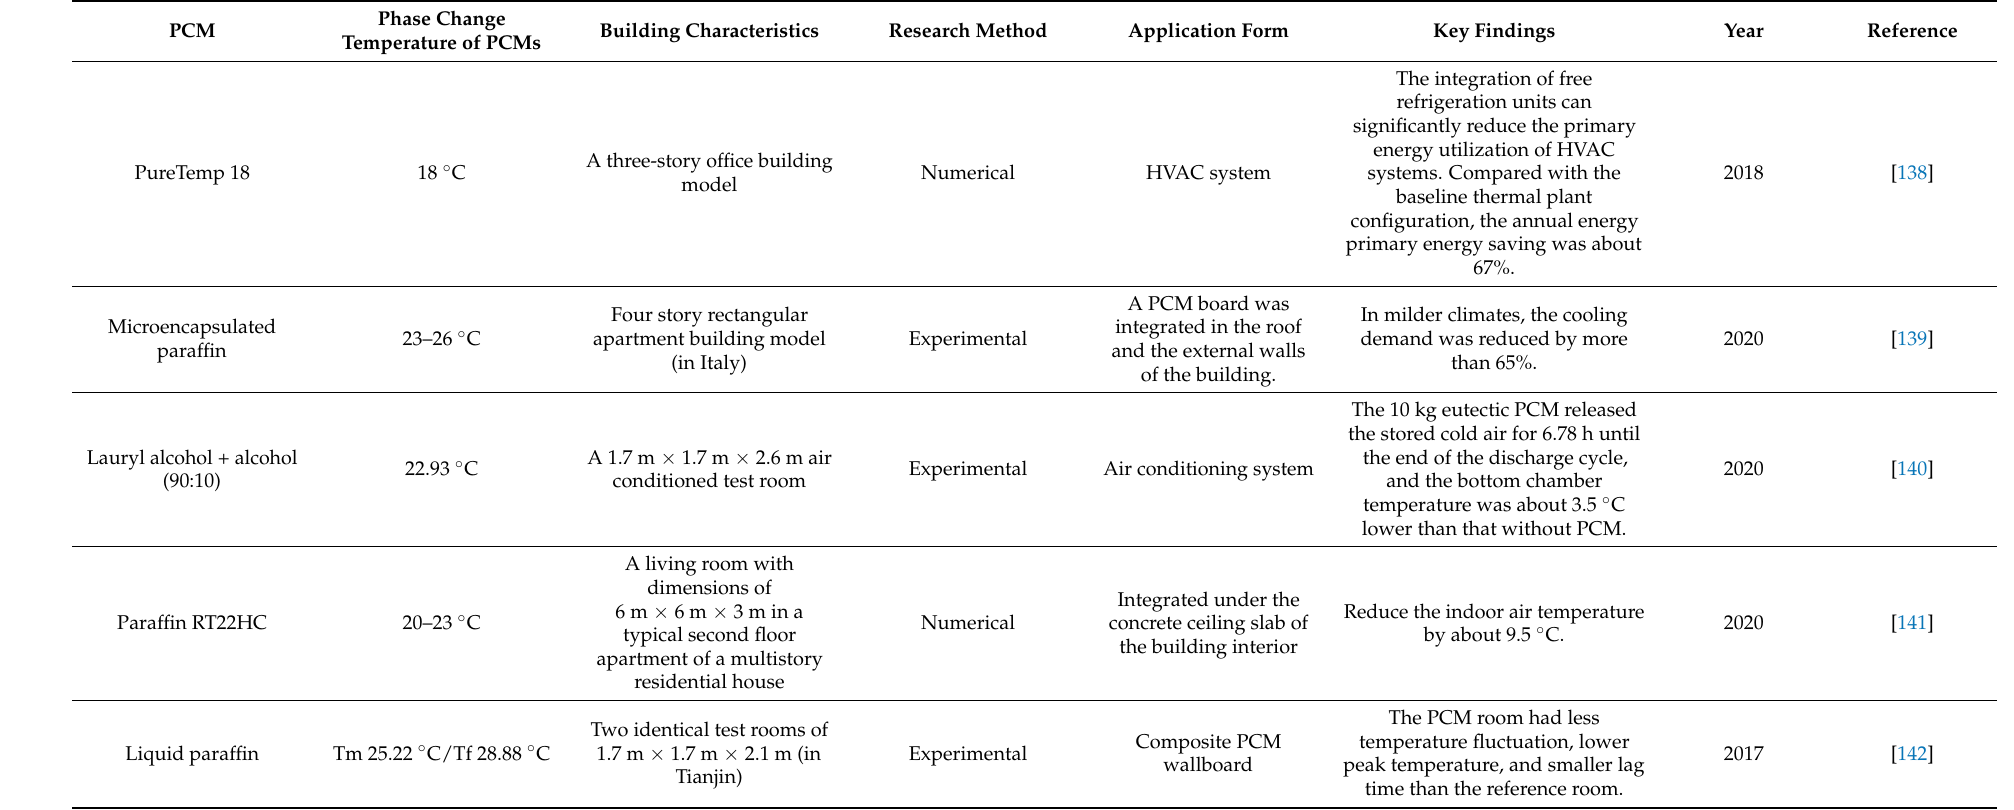
Table 10. Typical applications of PCMs for CTES in